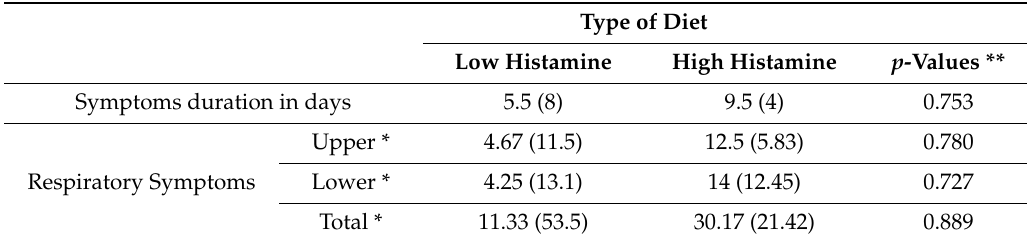
Table 3. Comparisons between the median number of days with symptoms and median symptom score during the two intervention